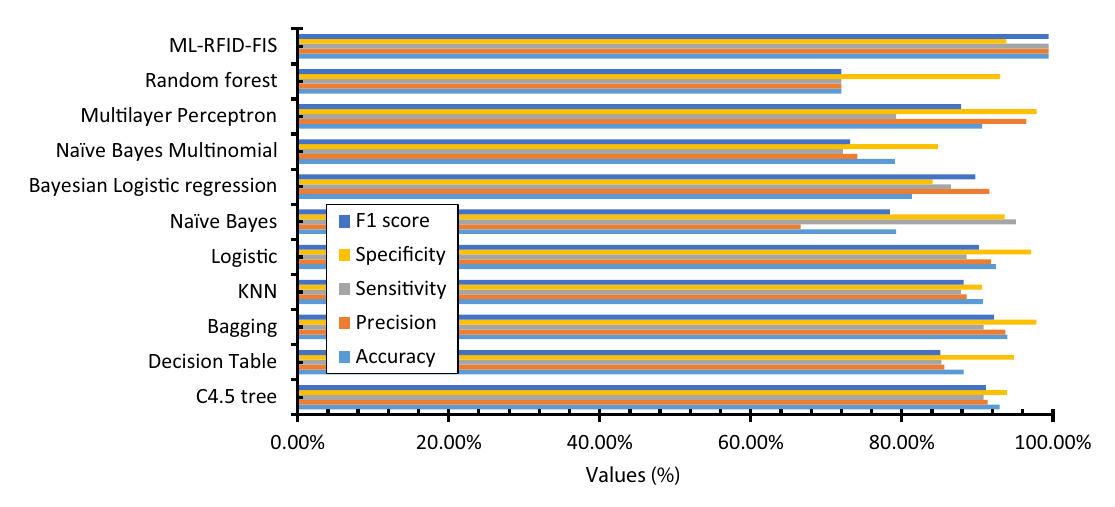
Fig. 5 Overall performance comparison of the